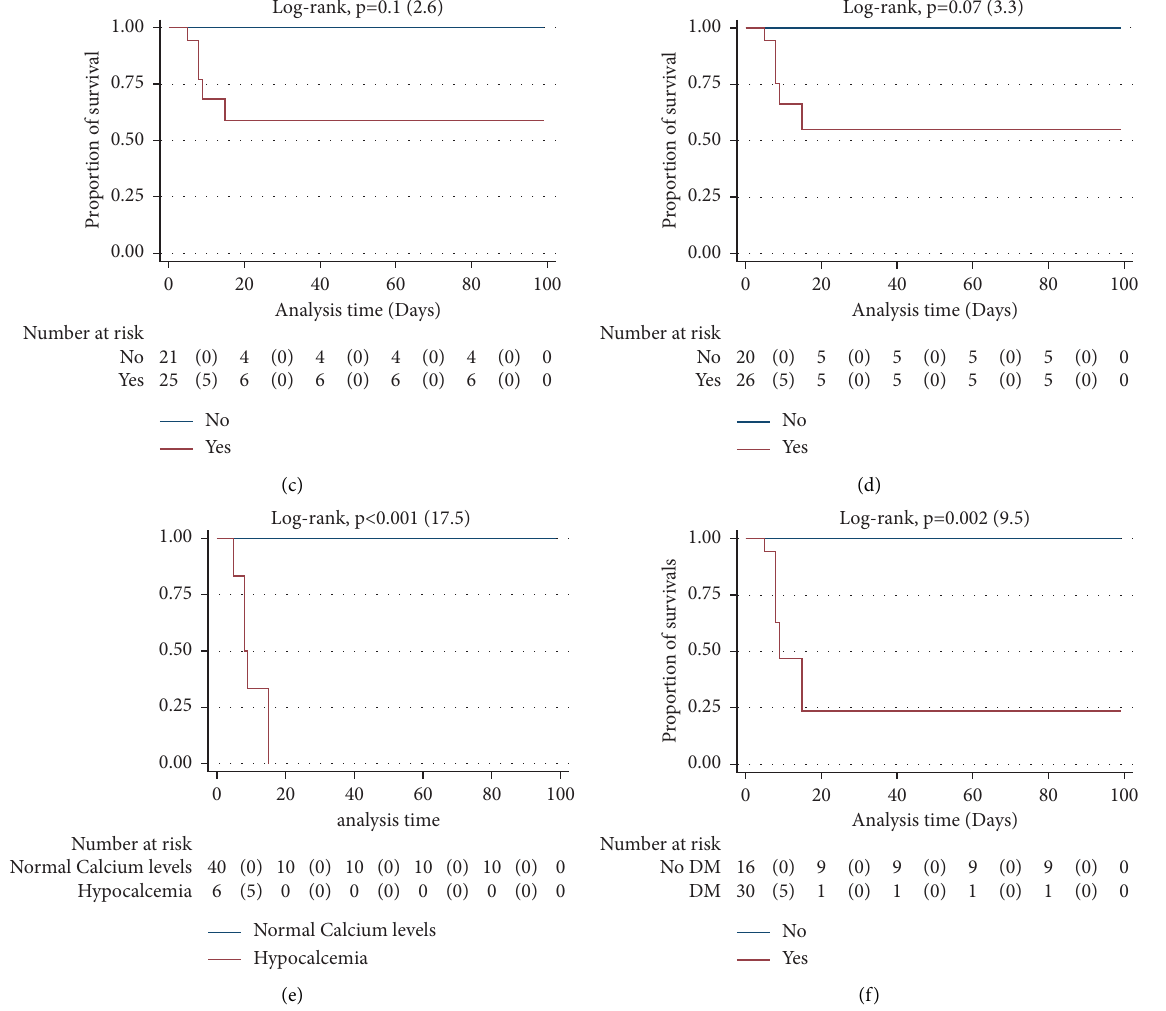
Figure 3: Kaplan–Meier cumulative proportion of unadjusted survival curves for SARS-CoV-2 infected individuals only (cases) between (a) those with normal and abnormal (yes) coagulation, (b) ANCA-positive and -negative patients, (c) elevated (yes) and normal levels of CRP, (d) elevated (yes) and normal levels of ESR, (e) calcium levels, and (f) presence or absence of